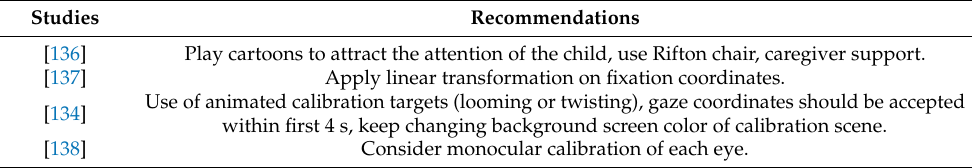
Table 5. Recommendations for calibration and screening for children and